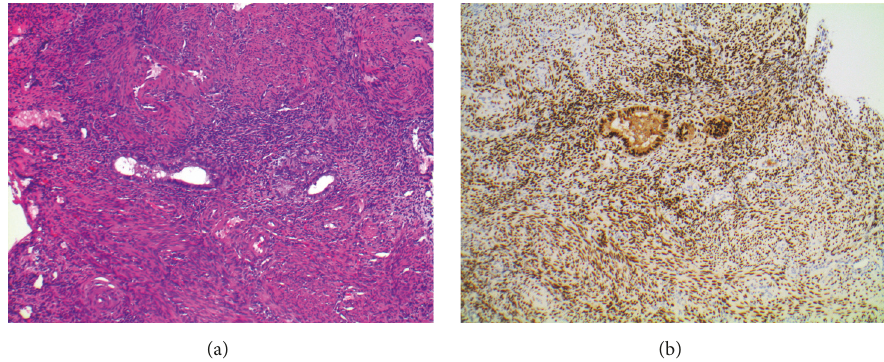
Figure 3: (a) Staining of the colonic nodule shows active proliferative endometrial glands and stromal tissue (hematoxylin and eosin, 40x). (b) Immunohistochemistry demonstrates diffusely positive staining for the estrogen receptor in a pattern consistent with endometrial tissue (100x).